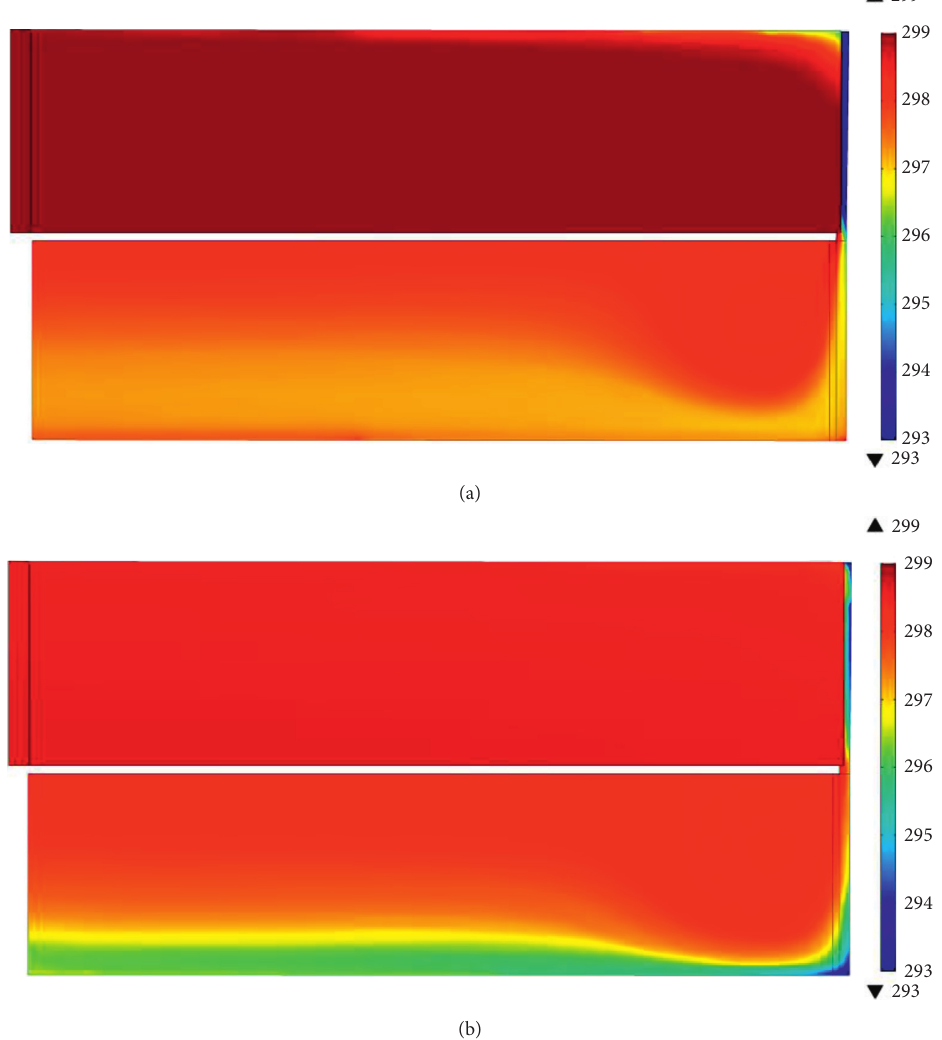
Figure 5: Effect of the inclination angle of the reactor on air-water surface temperature distribution K at Re � 9000, water depth � 5.6mm, and aspect ratio � 180 for reactor inclined at (a) 1 ° and (b) 2 ° in June (XY-plane).